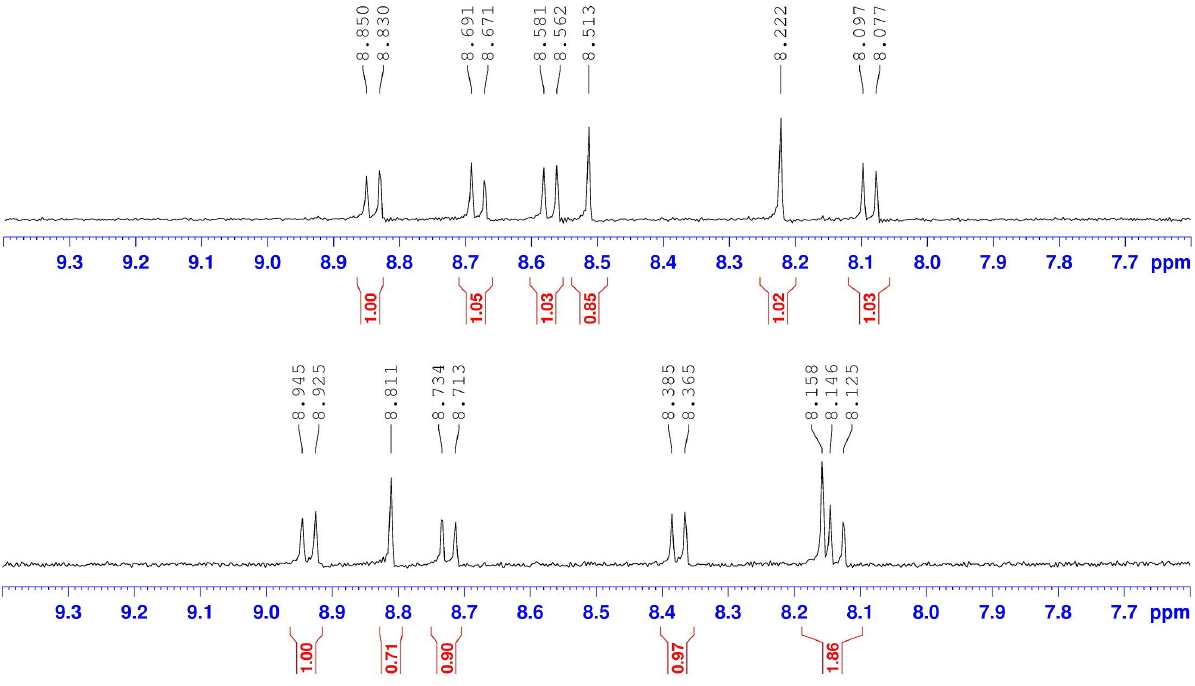
Figure 2. The 1 H-NMR (400 MHz, CDCl